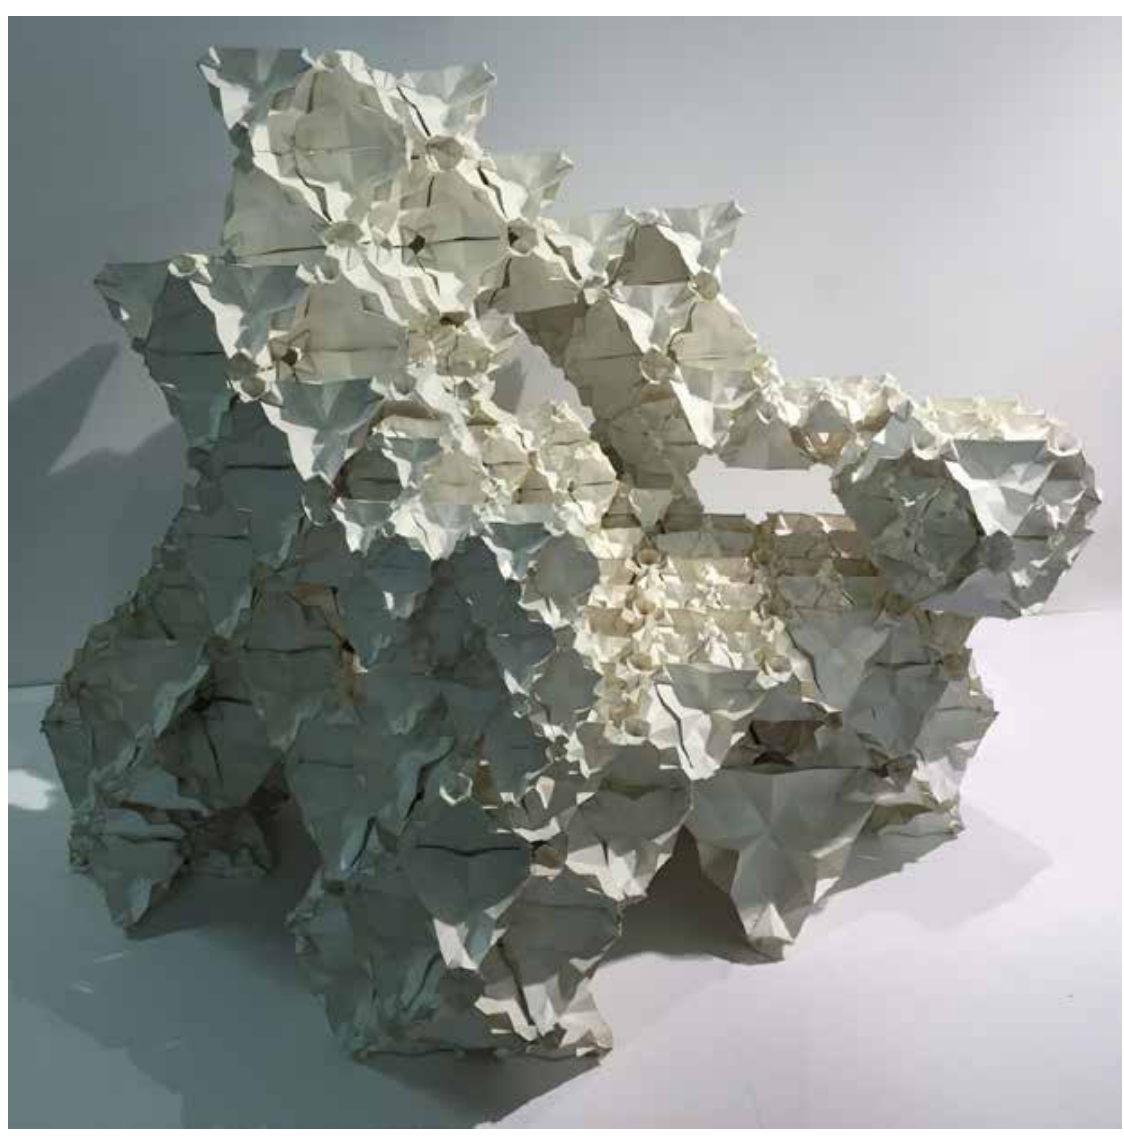
Figure 21: Increase (2015). Paper, Resin.Design: Daniel Widrig, Soomeen Hahm, Stefan Bassing. Team : Chao Zheng, Chang Chen Wei, Chao-Fu Yeh, Jinlian Wang. Source: